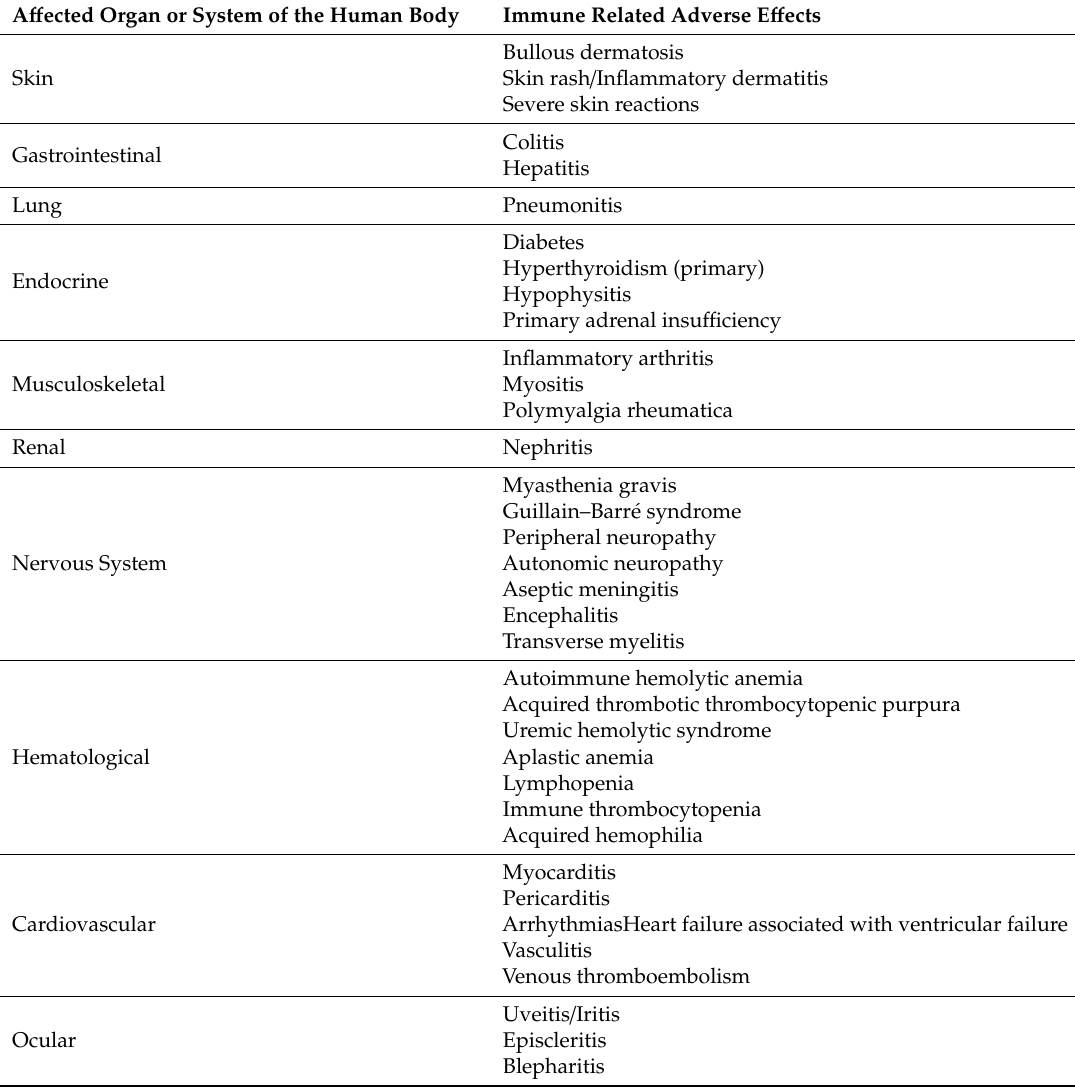
Table 3. Most common adverse e ff ects associated with ICPI (adapted from ref. [4]). A ff ected Organ or System of the Human